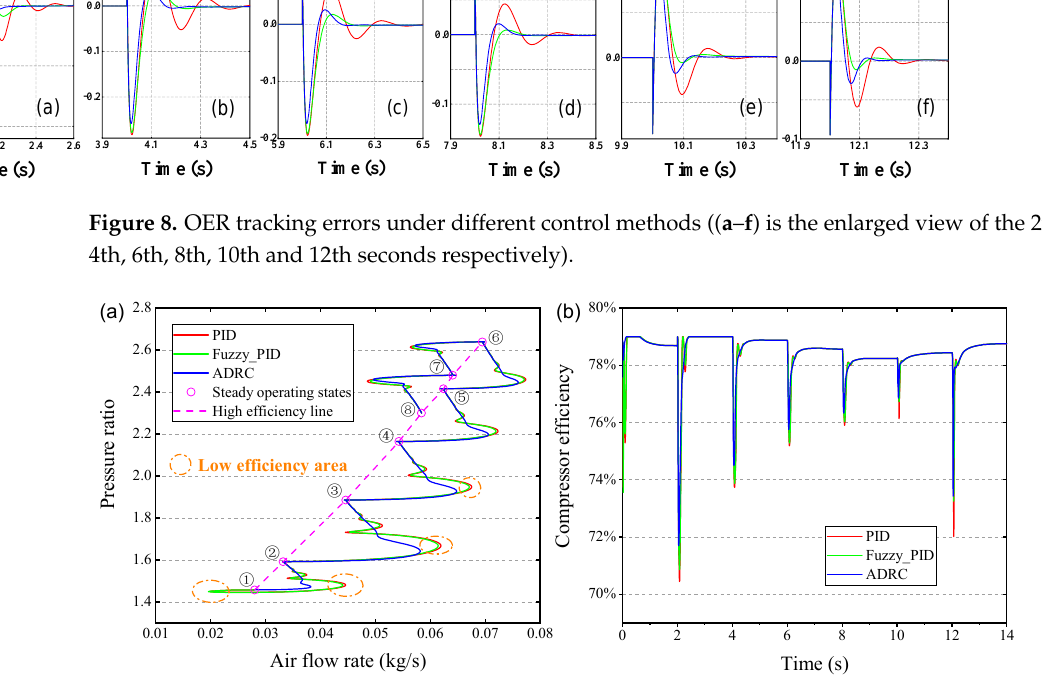
Figure 9. Compressor trajectory performance under different control methods: ( a ) the instantaneous tracks of compressor motion; ( b ) the instantaneous η cp . Table 3. Control performance evaluation for different methods.